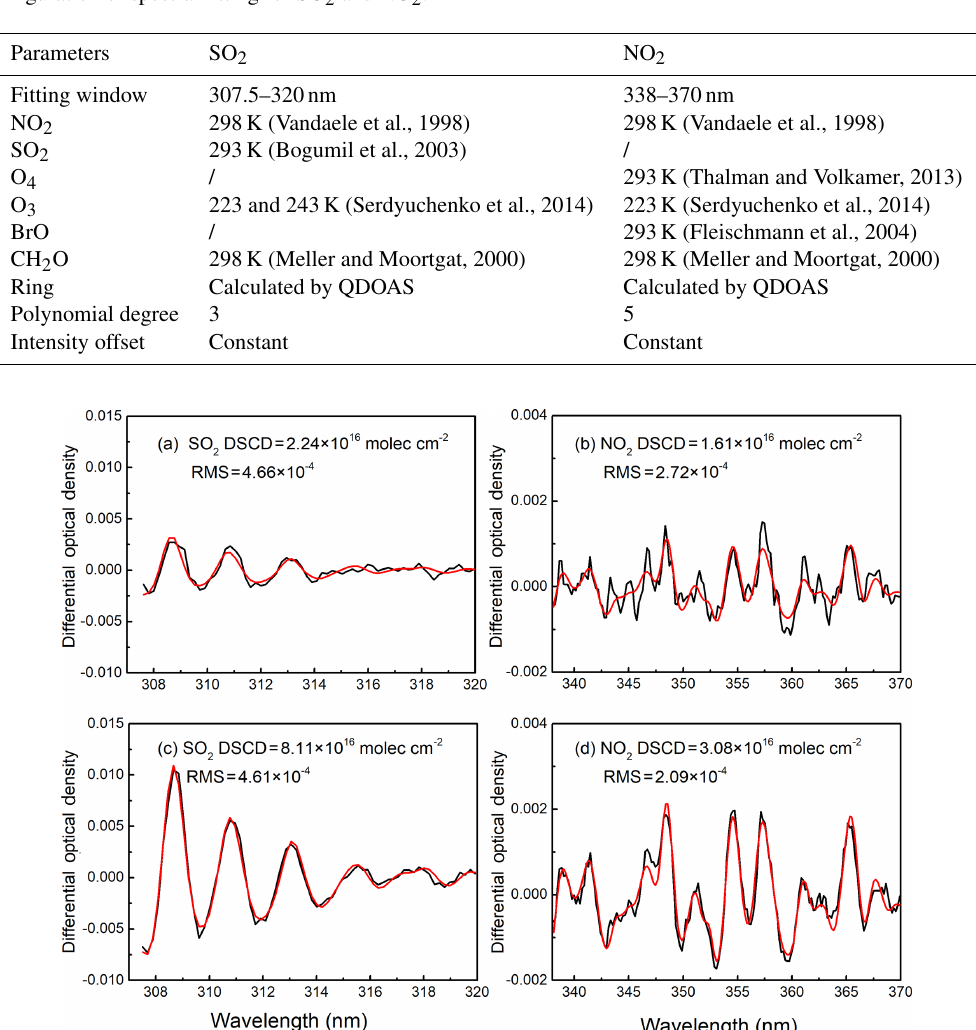
Table 2. The configuration of spectral fitting for SO 2 and NO 2 .